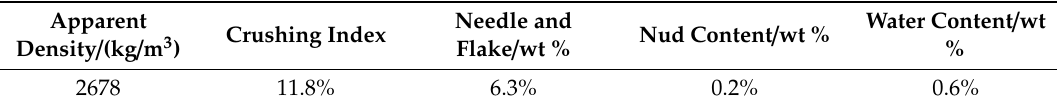
Table 5. Physical properties of coarse